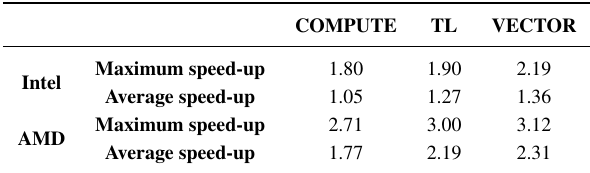
Table 4. Comparison of Homogeneous